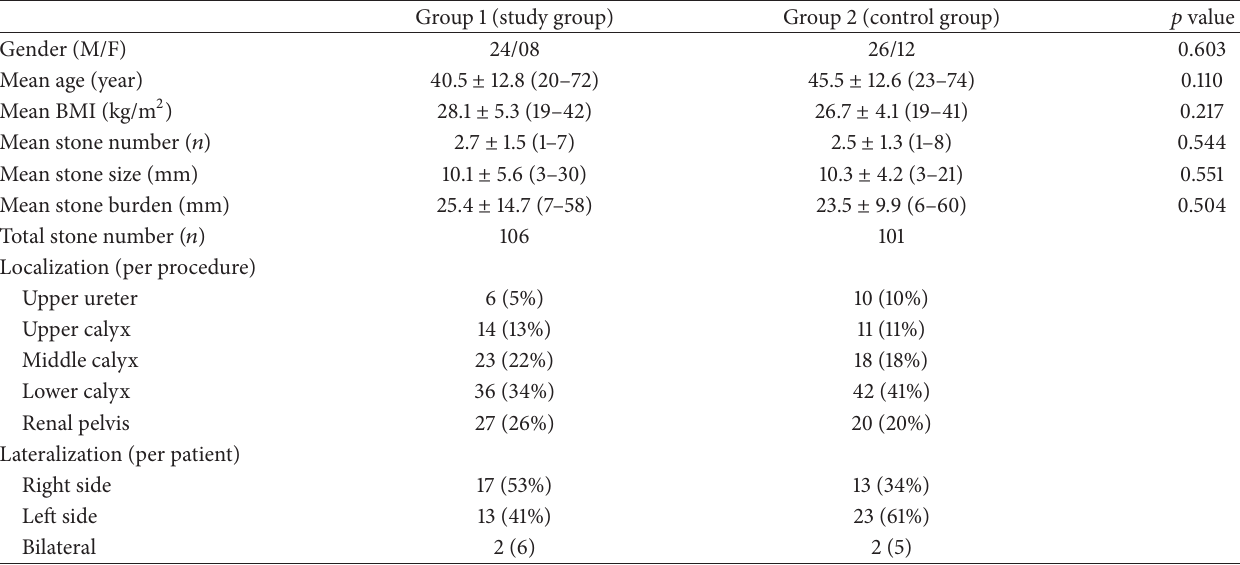
Table 1: Patient demographics and preoperative stone characteristics.